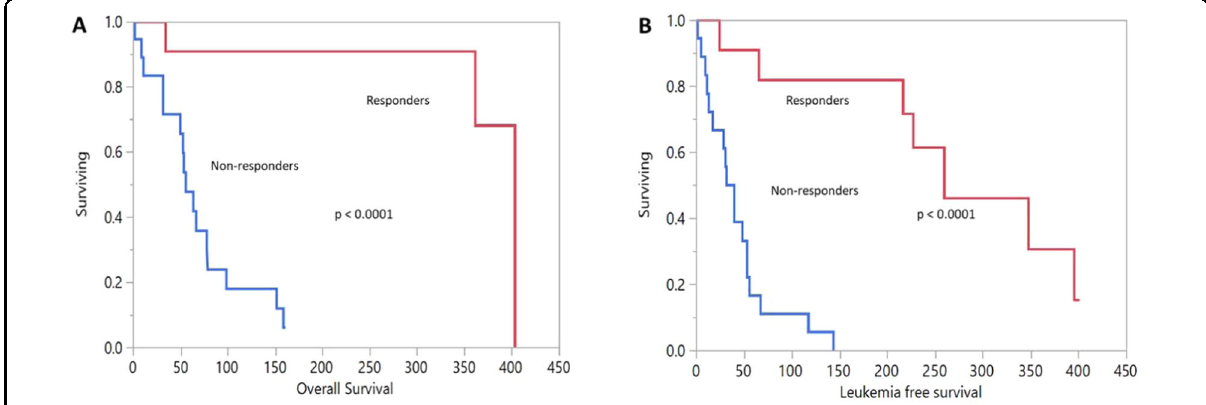
Fig. 1 Salvage use of venetoclax-based therapy for relapsed AML post allogeneic hematopoietic stem cell transplant. A Overall survival and B leukemia-free survival in responders vs non-responders in patients receiving VEN for post-transplant